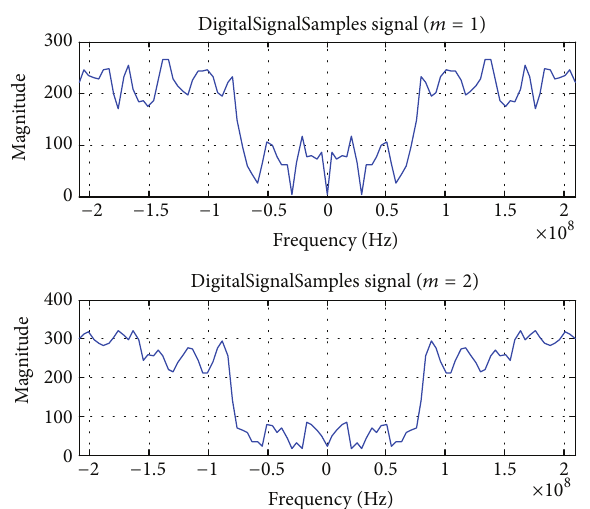
Figure 8: The beneficial spectrum aliasing from two channels.